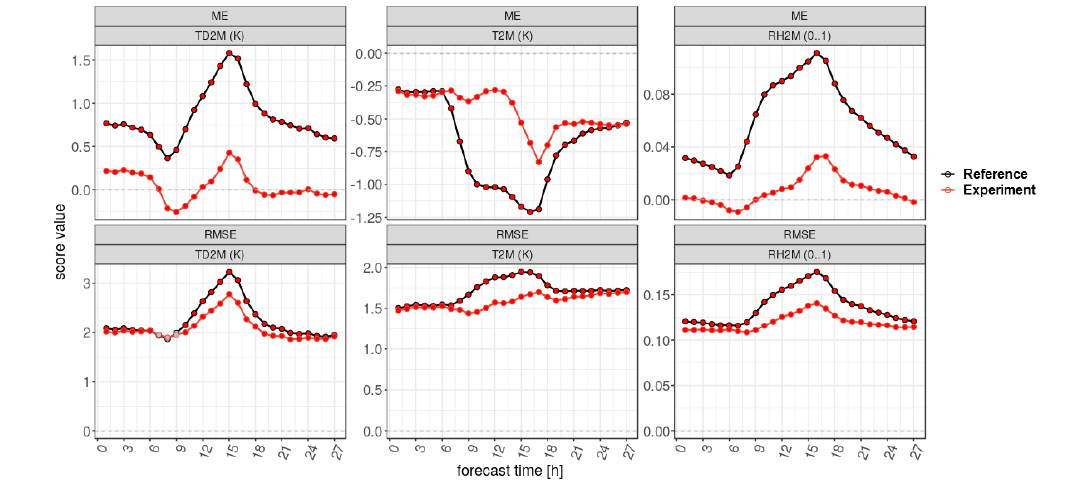
Figure 12. Same as Figure 11 but for the mean error (ME), or bias, and the root mean square error (RMSE) of TD2M, T2M, and RH2M. Filled circles indicate that the differences are statistically